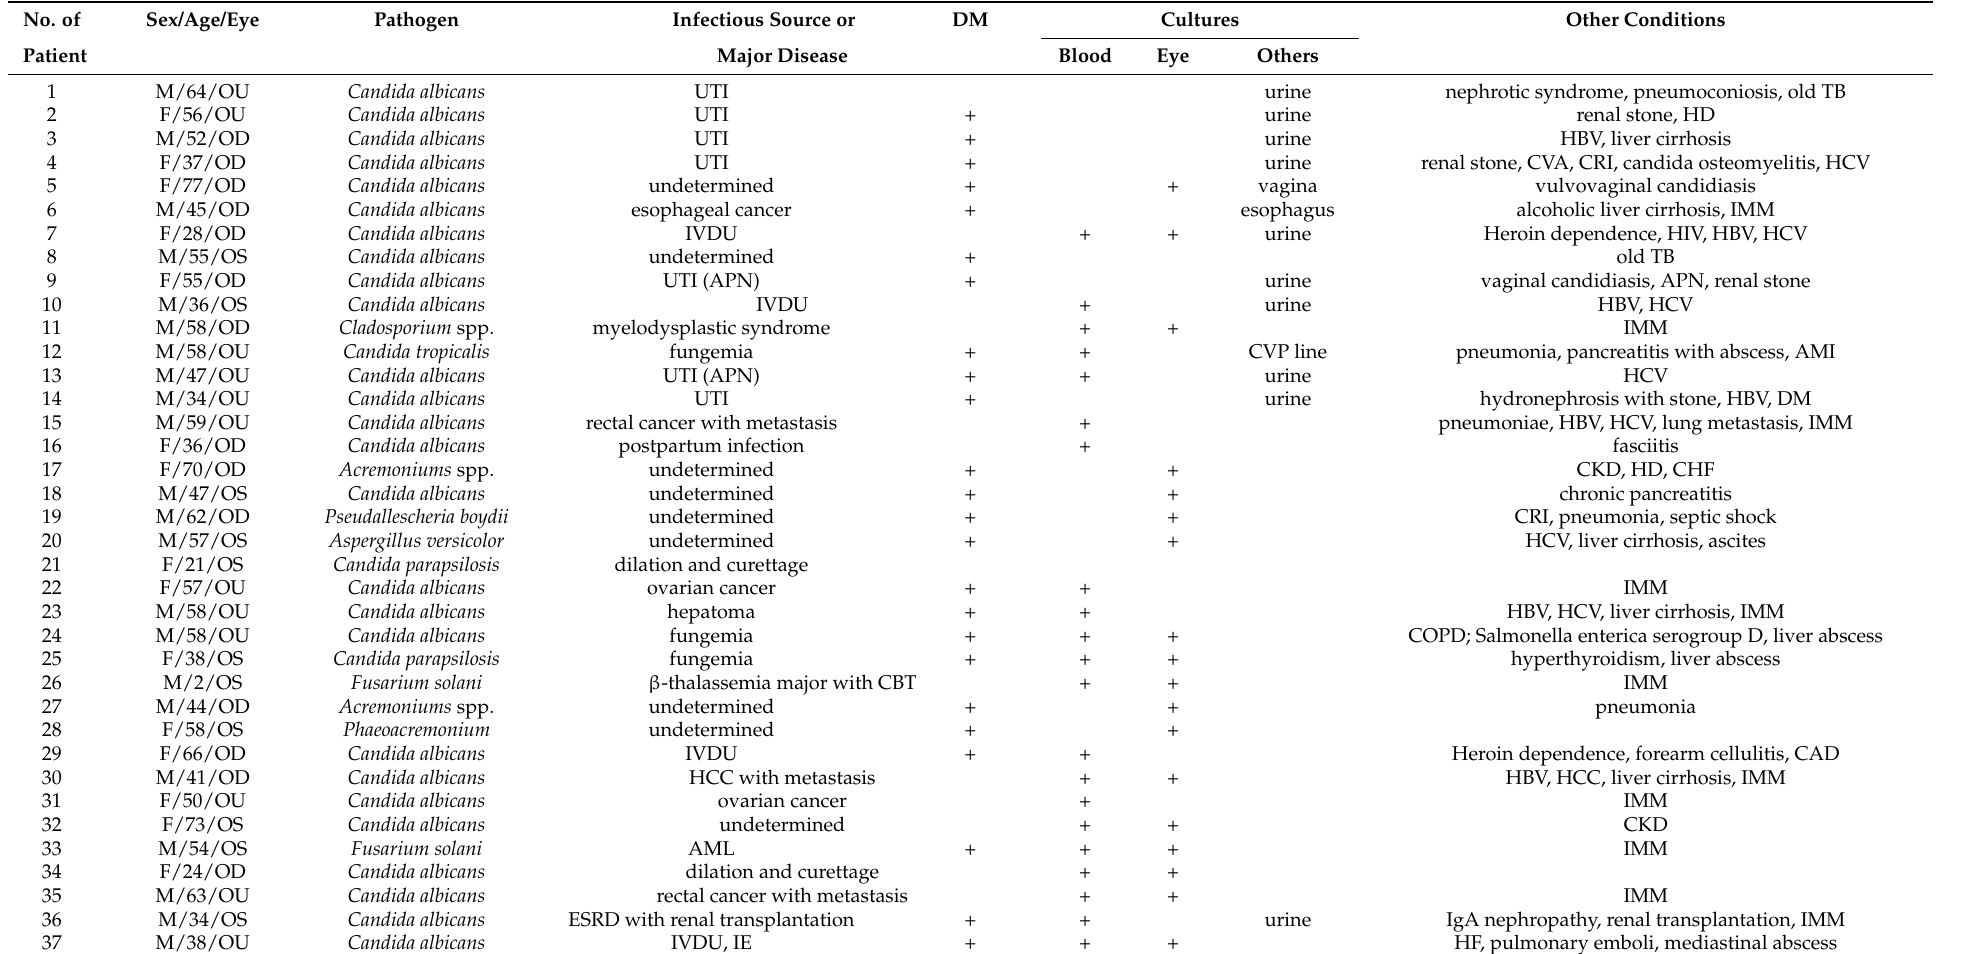
Table 1. Demographics of patients with endogenous fungal